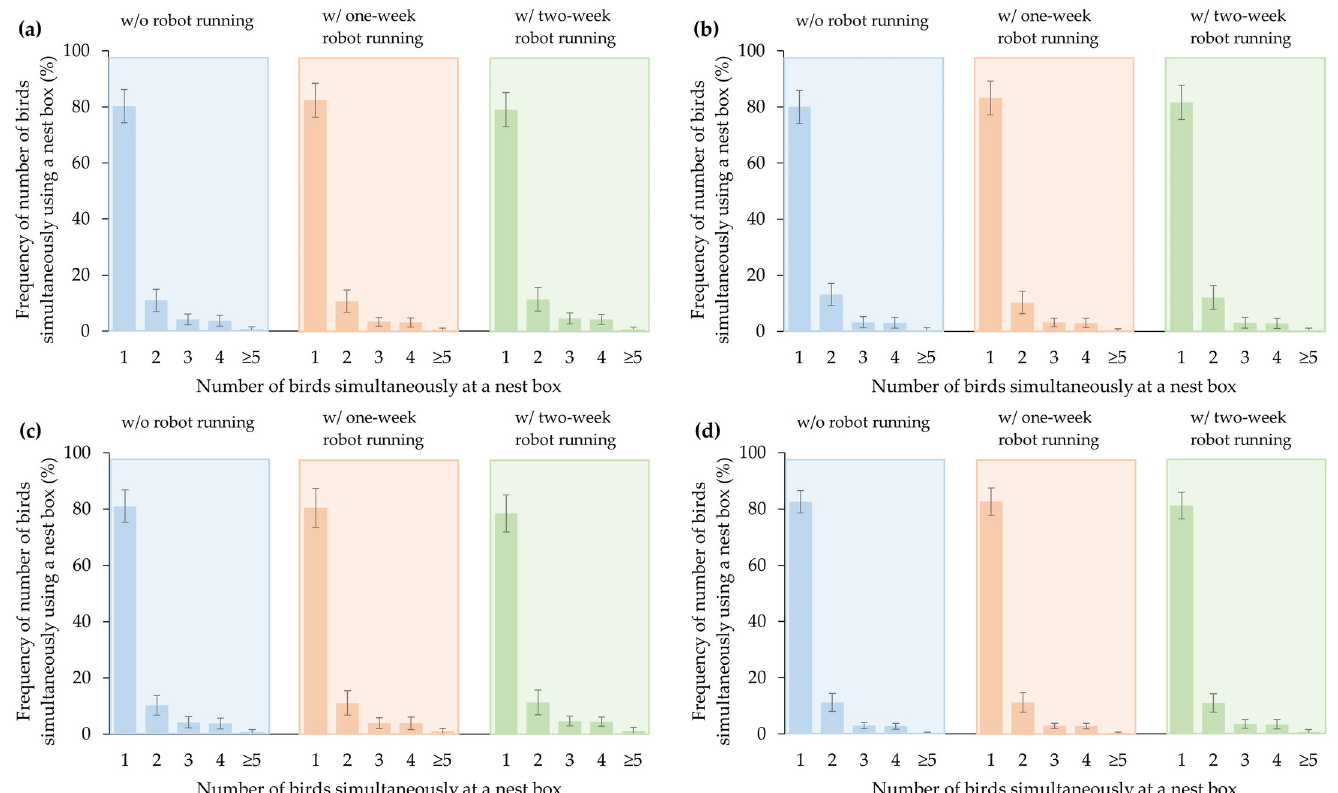
Fig 5. Frequency of number of birds simultaneously using a nest box with regard to different sections of time: (a) during 7:00 to 13:00 in weeks 35–38; (b) during 7:00 to 13:00 in weeks 40–43; (c) in a day in weeks 35–38; and (d) in a day in weeks 40–43. ‘w/’ and ‘w/o’ represent with and without, respectively.